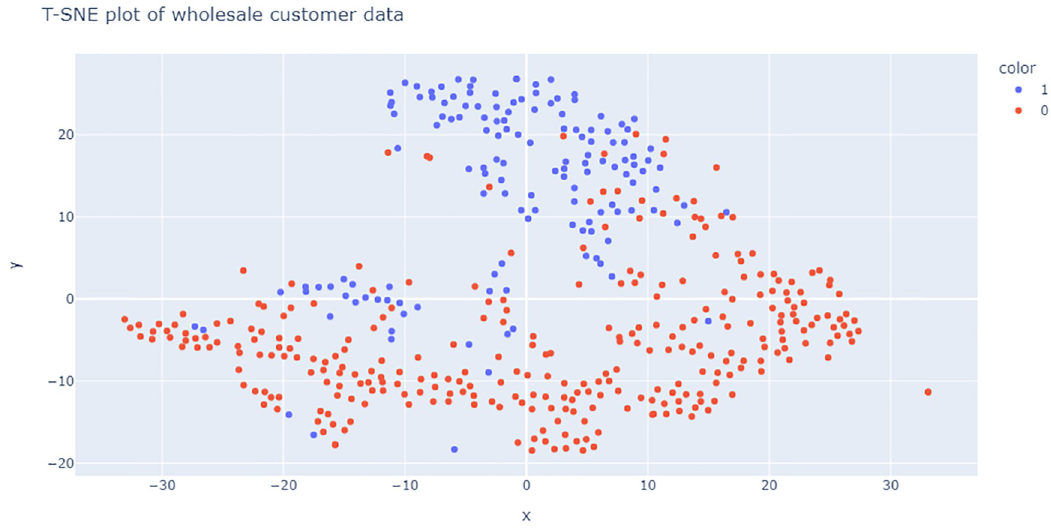
Fig 14. T-SNE plot of wholesale customer